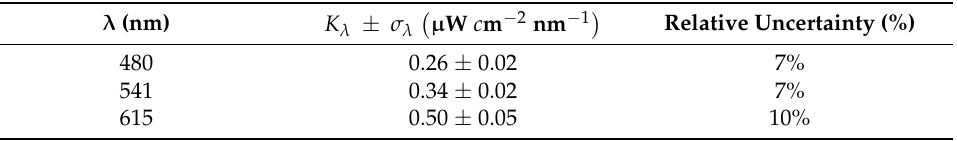
Table 3. Calibration coefficients ( K λ ) of each channel of the sky-camera and its absolute and rela- tive